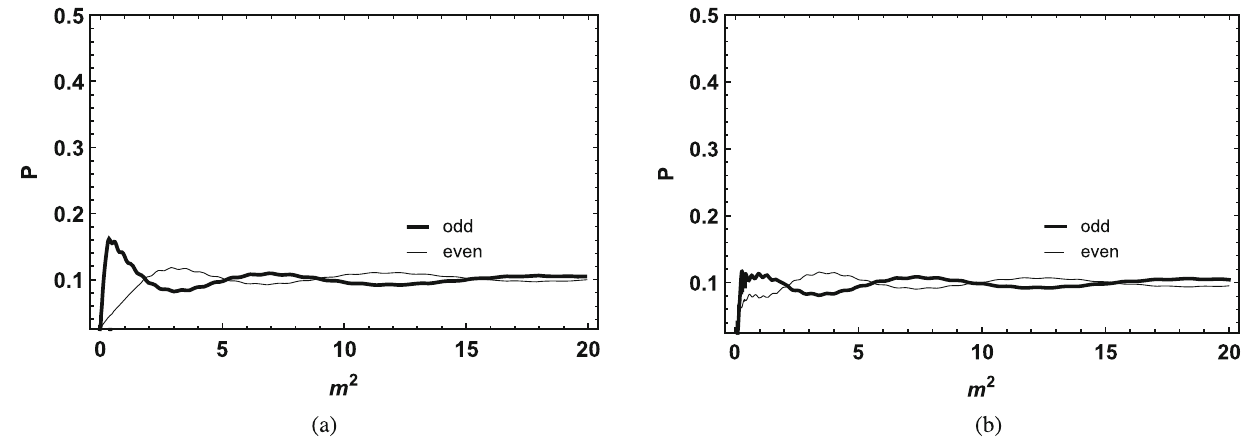
Fig. 7 The behavior of the relative probability P ( m ) for G 1 (φ) with n = 2, b = 4 k = − 0 . 3 and p = λ = 1. a Gauge field. b KR field move away from the origin of the brane (Fig. 8a, b). For the the other hand, even solutions do not show evident peaks. For KR field, when we vary k , we modify the amplitudes of the the KR field, the odd solutions show a peak at m 2 = 0 . 19 (Fig. 9b). Something similar happens with even solutions. oscillations,buttheydonotdepartfromtheorigin(Fig.8c,d). For G 2 with n = 2, in the case of the gauge field, when In Fig. 9, we show the behavior of the relative probability P ( m ) , for G 2 (φ) , with n = 2. The odd solutions for the we decrease the value of k , we modify the amplitudes of the gauge field show a sharp peak for m 2 = 0 . 45 (Fig. 9a). On oscillations that tend to move towards the origin (Fig. 10a, b). The same is true for the KR field (Fig. 10c,